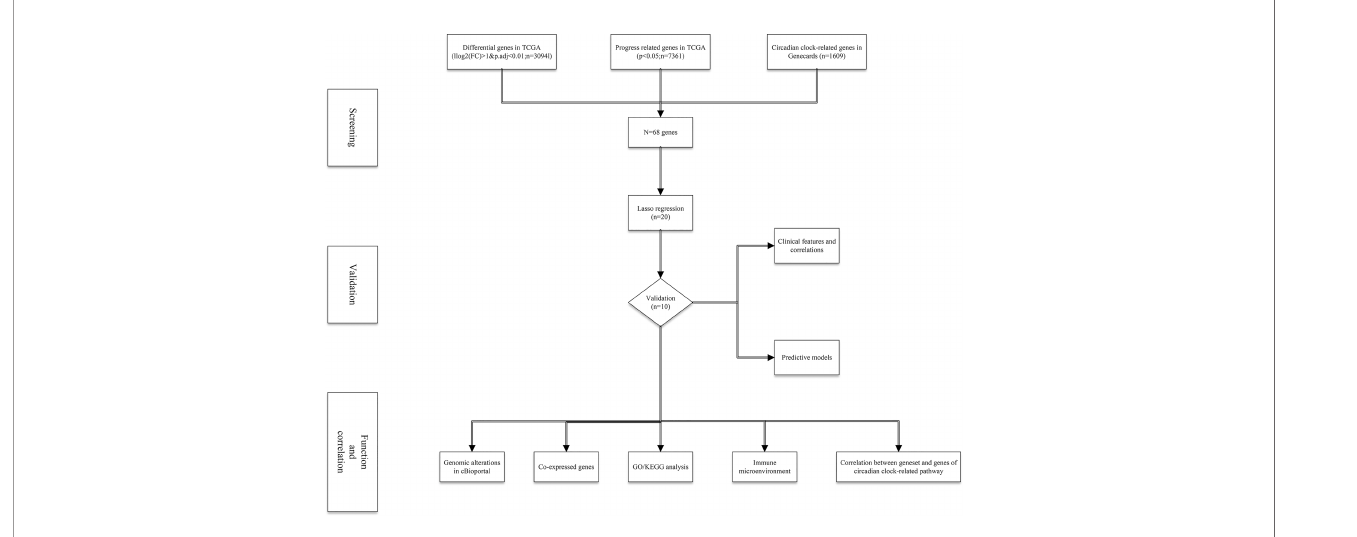
FIGURE 1 | The fl ow chart of this